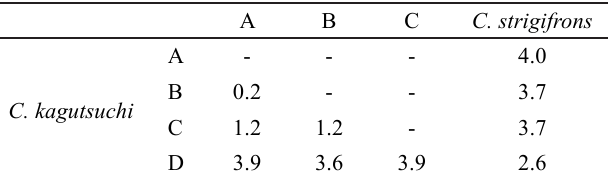
Table 1. Substitution rates (%) of mtDNA COI/II regions (829 bp)